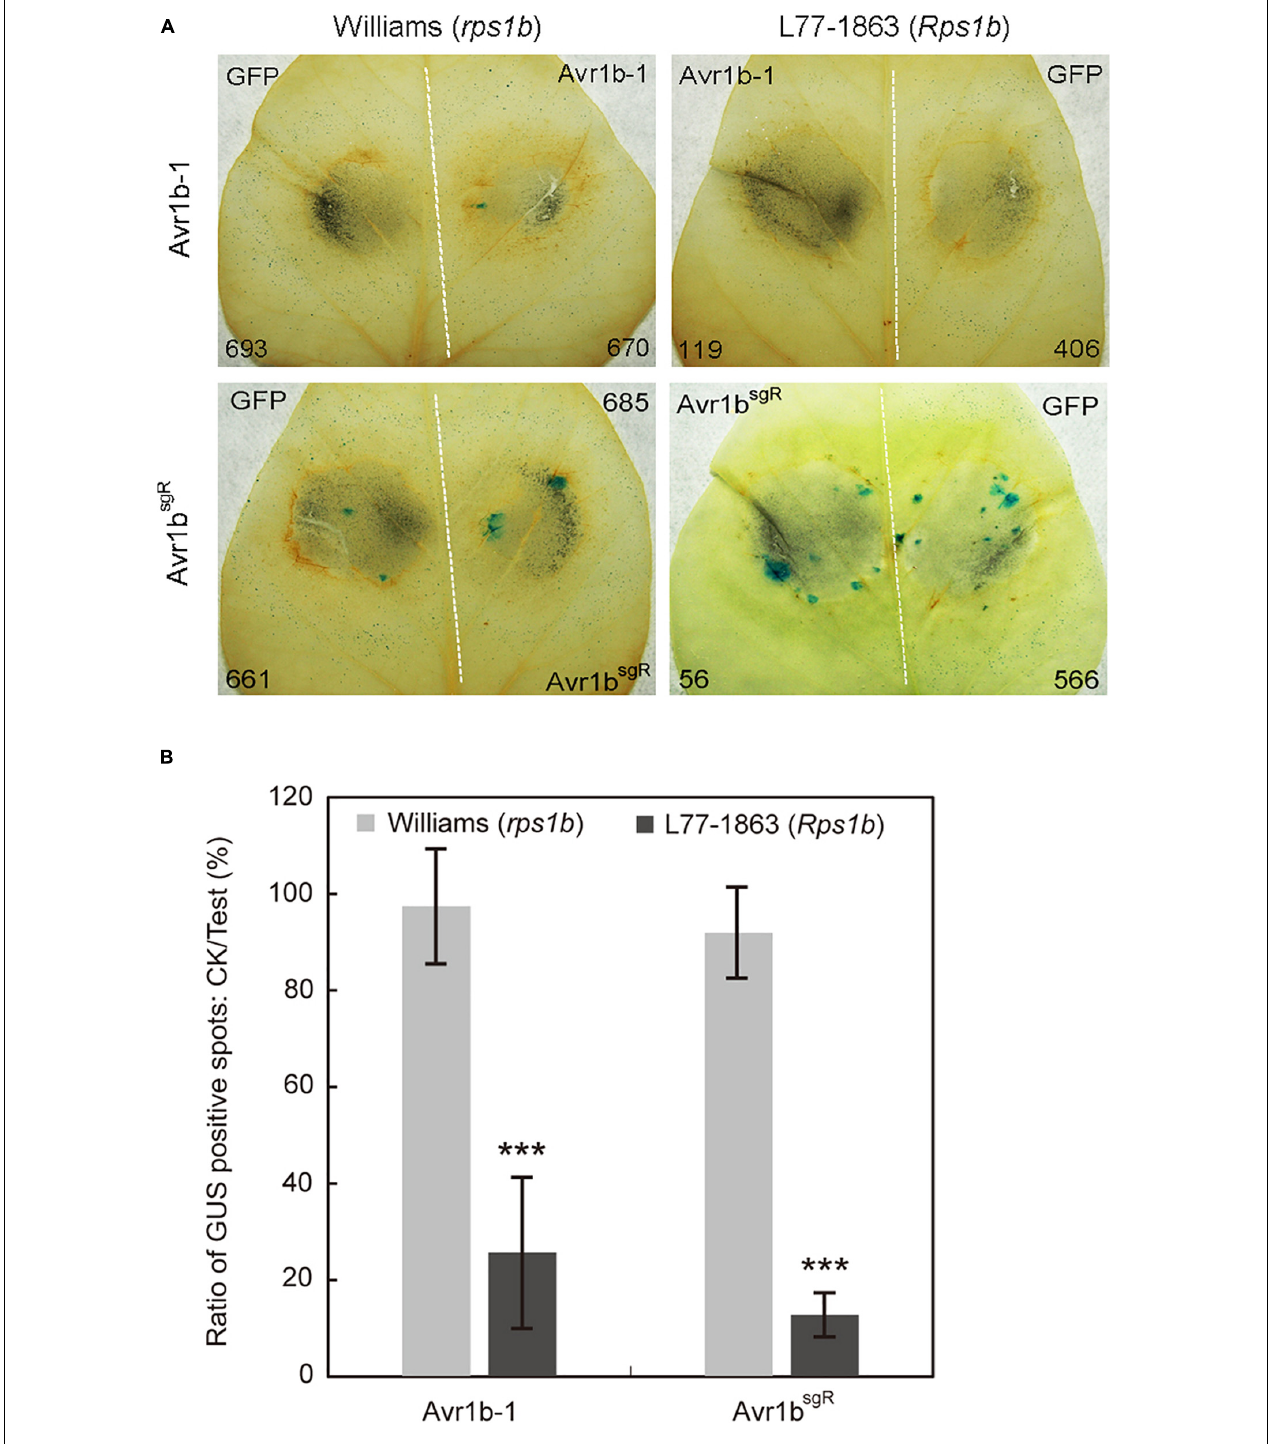
FIGURE 5 | Transient expression of Avr1b-1 sgR leads to cell death in Rps1b soybean leaves. (A) Soybean leaves from Williams ( rps1b ) and L77-1863 ( Rps1b ) were subjected to double-barreled particle bombardment with pairs of samples containing GUS reporter DNA plus either Avr1b sgR DNA or GFP control DNA. After staining, the numbers of blue spots on Williams ( rps1b ) and L77-1863 ( Rps1b ) leaves were counted. A functional Avr1b-1 gene is expected to significantly reduce the number of blue spots on L77-1863 ( Rps1b ) leaves, but not Williams ( rps1b ) leaves, due to triggering Rps1b -mediated cell death. The white dotted line separates the two bombardment sites. Numbers of GUS spots counted are indicated. (B) Ratios between the numbers of GUS spots produced in the presence of Avr1b-1 vs. control GFP DNA on each leaf, averaged from 10 soybean leaves, in a single experiment. Error bar represents the mean ± standard deviation. The significance of the difference between Williams and L77-1863 leaves was determined by the Wilcoxon rank sum test (Gu et al., 2011), *** P < 0.001.